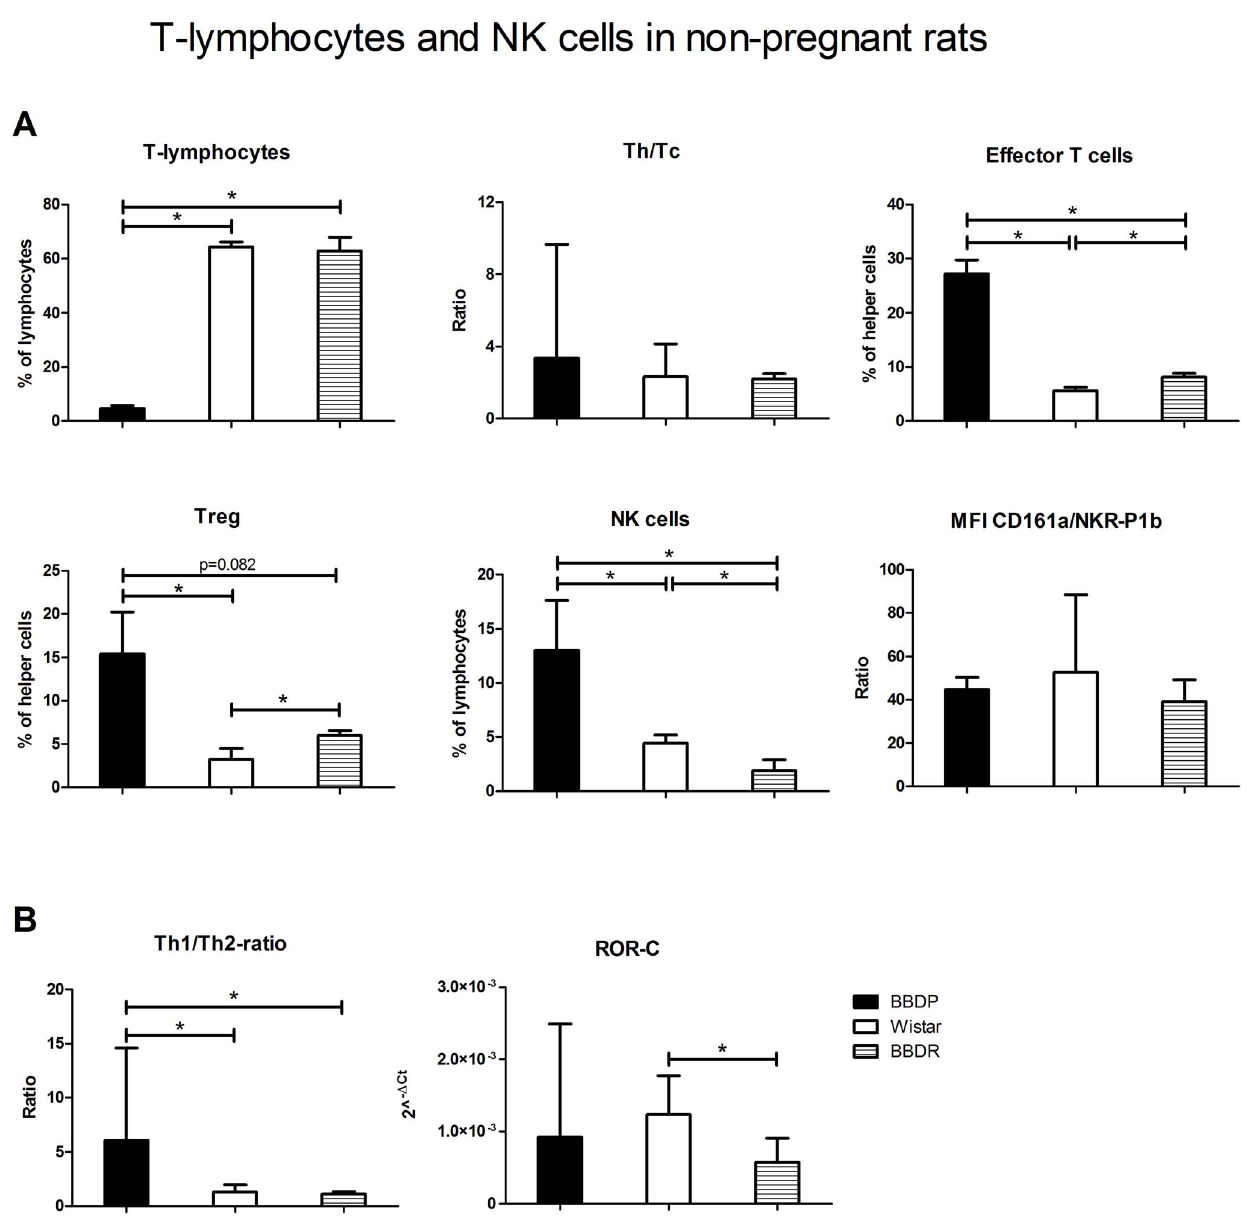
Figure 3. Lymphocyte subpopulations in non-pregnant rats. [A] The percentages of T-lymphocytes (of the total leukocyte population), the ratio of T-helper cells (Th) and cytotoxic T-cells (Tc), percentages effector T-cells (of Th; Teff), regulatory T-cells (of Th; Treg), NK-cells (of total lymphocyte population) and the ratio of MFI CD161a/NKR-P1b of NK-cells of the three non-pregnant rat-strains. [B] The Th1/Th2-mRNA ratio and mRNA expression of ROR-C of the three non-pregnant rat-strains. Values are expressed as median with range (Q 1 –Q 3 ), mRNA was expressed as Fold Change (2 ^ 2 D CT ). ‘*’ significant difference, Mann-Whitney U-Test, p , 0.05.